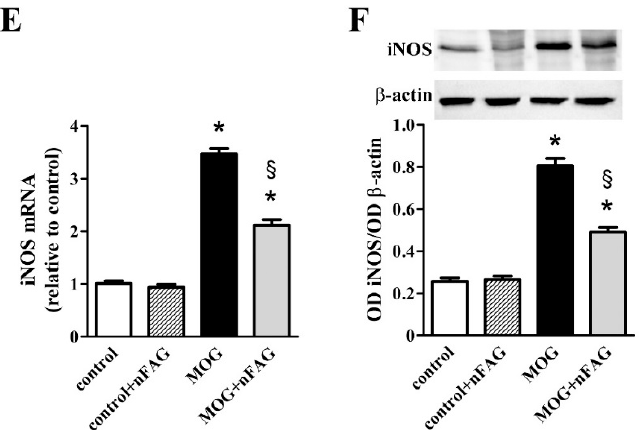
Figure 3. nFAG dietary supplementation reduces MOG-induced upregulation of markers of inflammation including intercellular adhesion molecule-1 (ICAM-1; A , B ); glial fibrillary acidic protein (GFAP; C , D ) and the inducible form of nitric oxide synthase (iNOS; E , F ). Levels were evaluated in control and MOG-treated mice, supplemented or not with nFAG. Transcripts ( A , C , E ) were evaluated by relative quantification with qPCR. Data were analyzed by the formula 2 −ΔΔ CT using Rpl13a as the internal standard. Proteins ( B , D , F ) were evaluated by western blot using β -actin as loading control. Data are shown as the mean ± S.E.M. ( n = 9 for each experimental group). * p < 0.001 versus control. § p < 0.001 versus MOG (one-way ANOVA followed by the Newman-Keuls multiple comparison post-hoc test). White bars, control mice; dashed bars, control mice with nFAG dietary supplementation; black bars, MOG-treated mice; grey bars, MOG-treated mice with nFAG dietary supplementation.